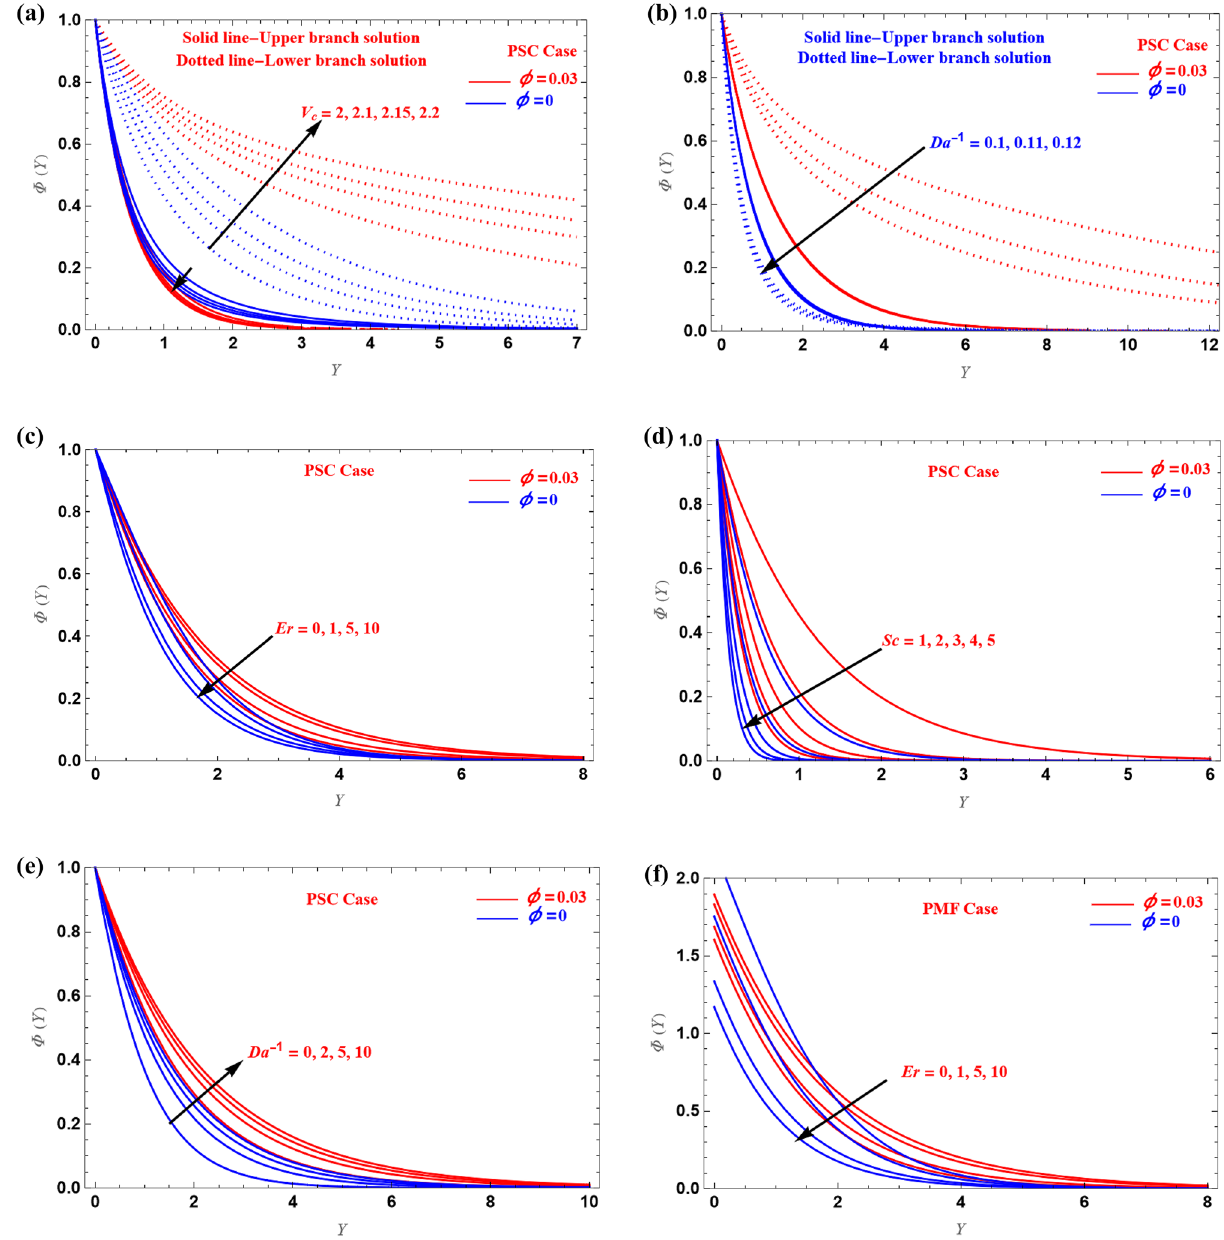
Figure 6. ( a – h ) Illustration of �( Y ) versus Y